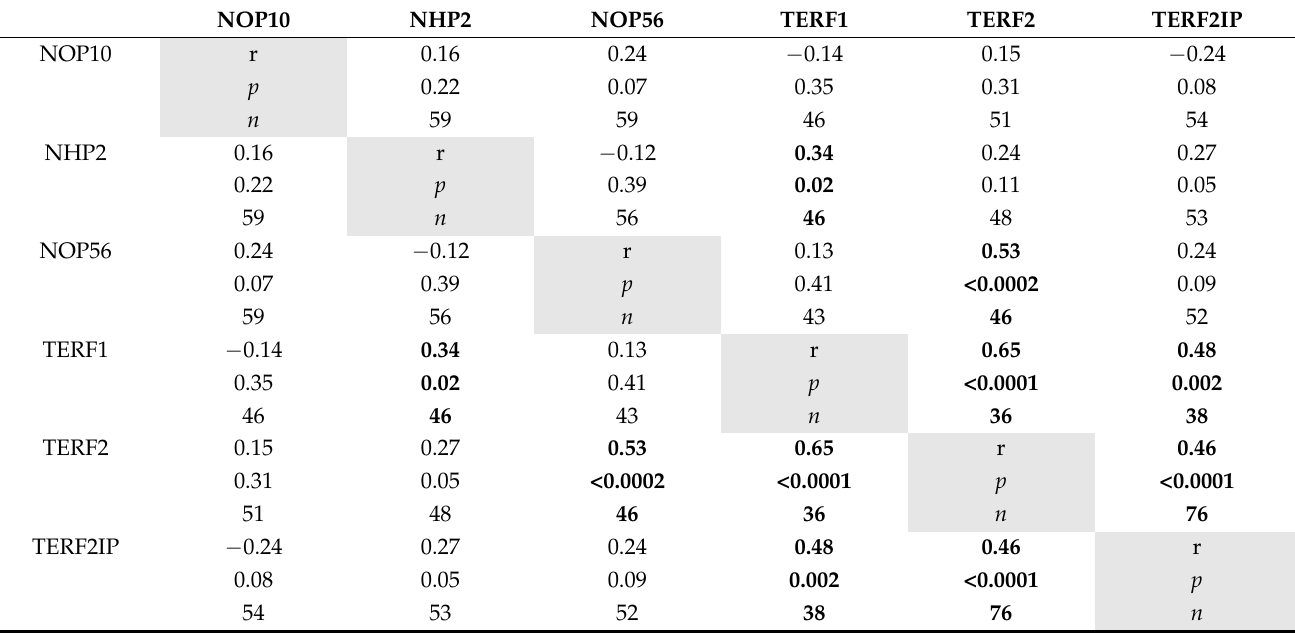
Table 3. Correlations between telomere and telomerase associated protein Quickscores for all